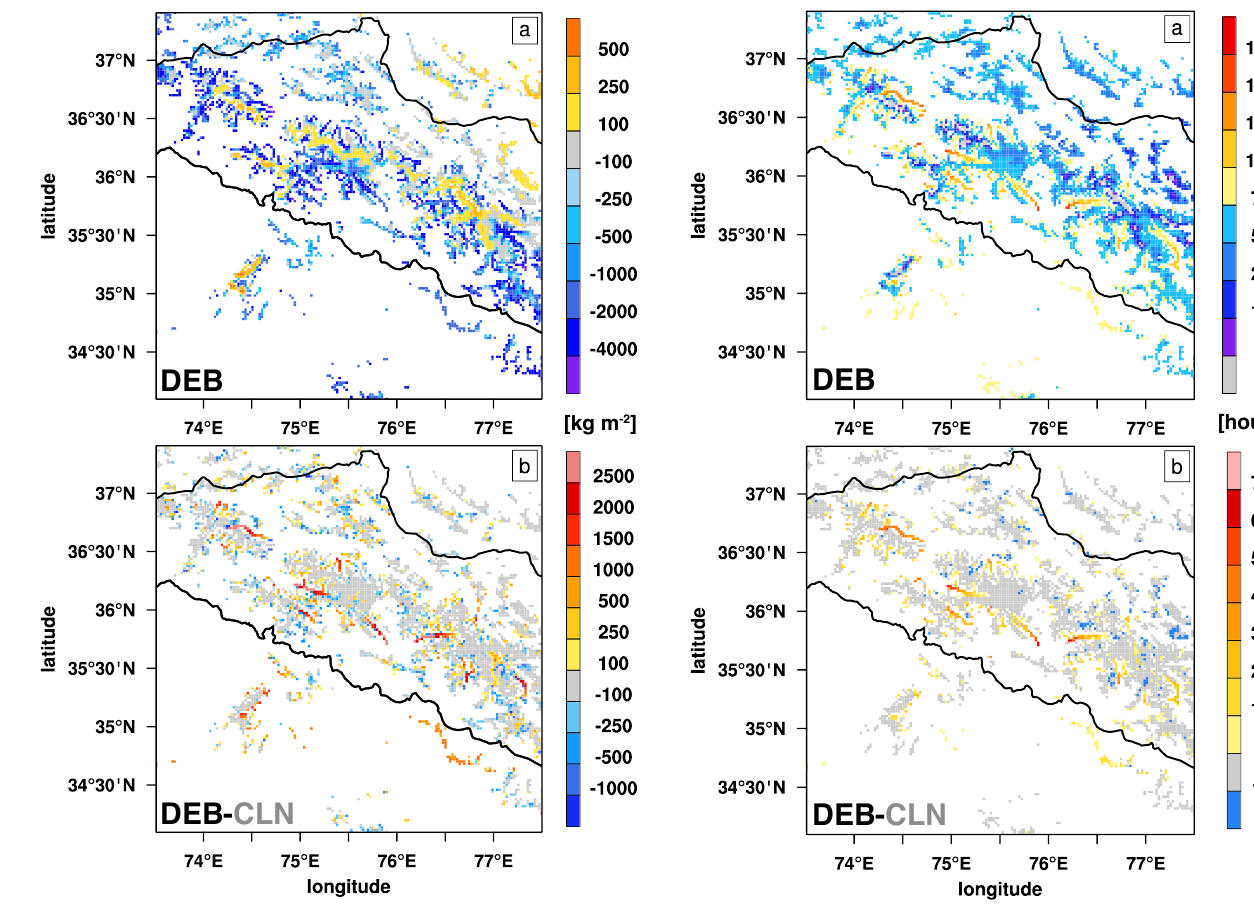
Figure 9. The number of hours where the surface temperatures reaches or exceeds the melting point between 1 July and 15 Septem- ber for (a) the DEB simulation and (b) the difference between CLN and DEB. The black contour delineates the region where centerline information was available from Rankl et al.